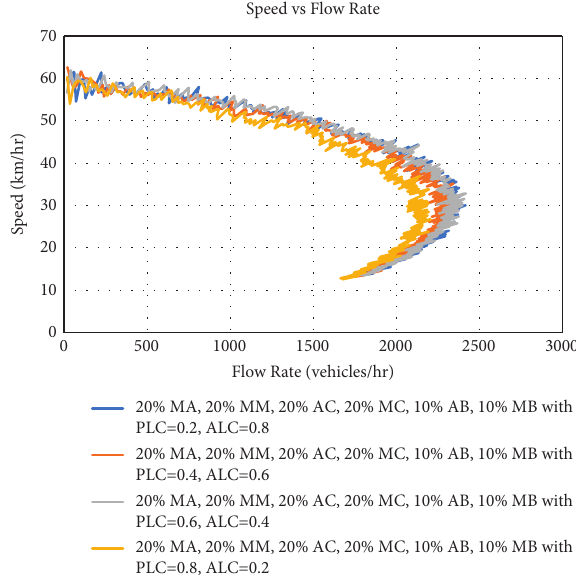
Figure 11: Speed vs. flow rate fundamental diagrams for different compositions of MA, MM, AC, MC, AB, and MB with different values of ALC and PLC.